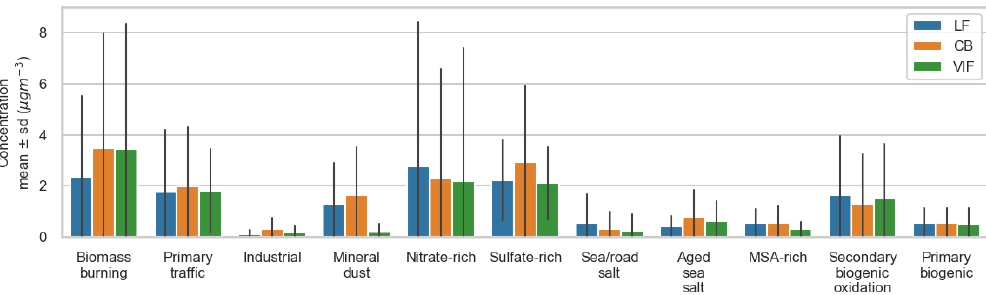
Figure 4. Factor contributions in µgm − 3 for the three sites (LF: blue, CB: orange, Vif: green). Bar plots depict the mean annual value and the standard deviation of daily variations.